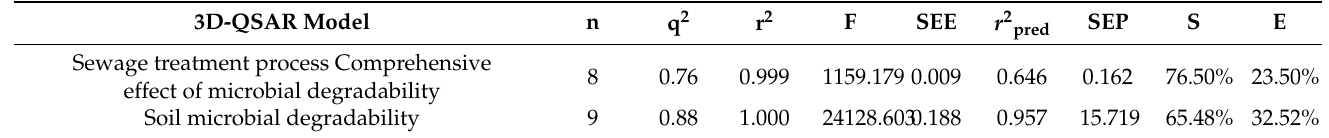
Table 2. Parameters associated with the PAEs of the W-3D-QSAR and S-3D-QSAR